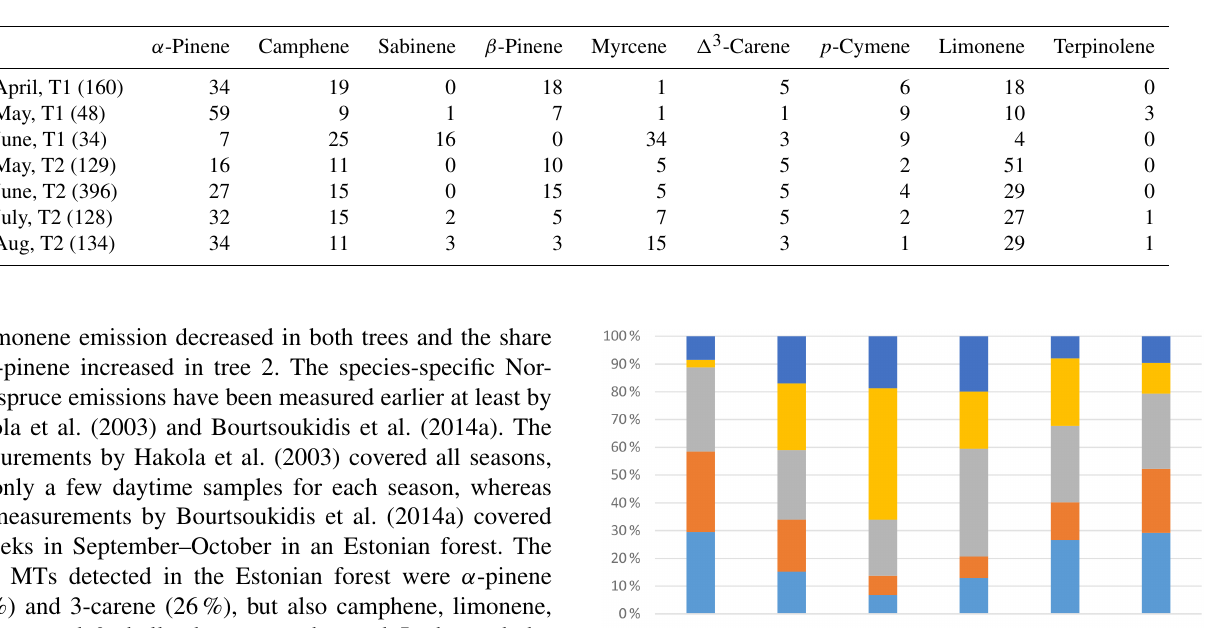
Table 4. Average monthly abundances (%) of emitted MTs. T1 (tree 1) includes 2011 and T2 2014 and 2015 measurements. The number of the measurements each month is in parentheses.